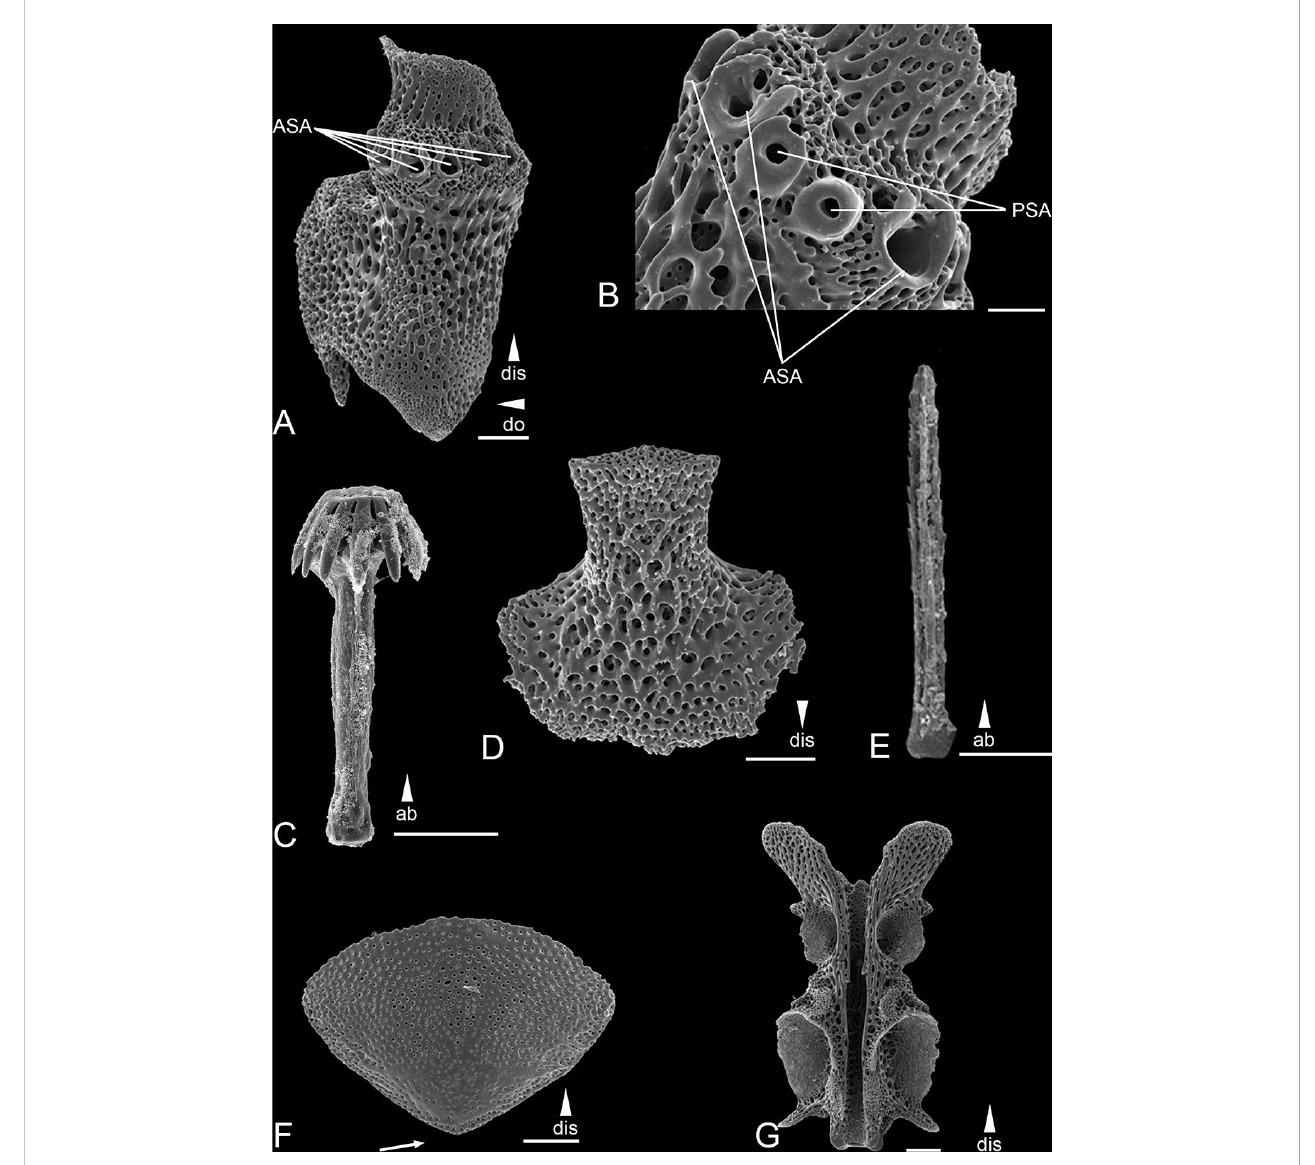
FIGURE 10 Scanning electron microscope images of the ossicles from Ophiotholia spathifer . (A) : Lateral arm plate; (B) : Close up lateral arm plate; (C) : Parasol-spine; (D) : Ventral arm plate; (E) : Arm spine; (F) : Dorsal arm plate; (G) : Arm Vertebrae. Scales: 50 µm (D) ; 200 µm (B, C, F) ; 500 µm (A, E) . ab, abradial; ASA, arm spine articulation; dis, distal; PSA, parasol spine